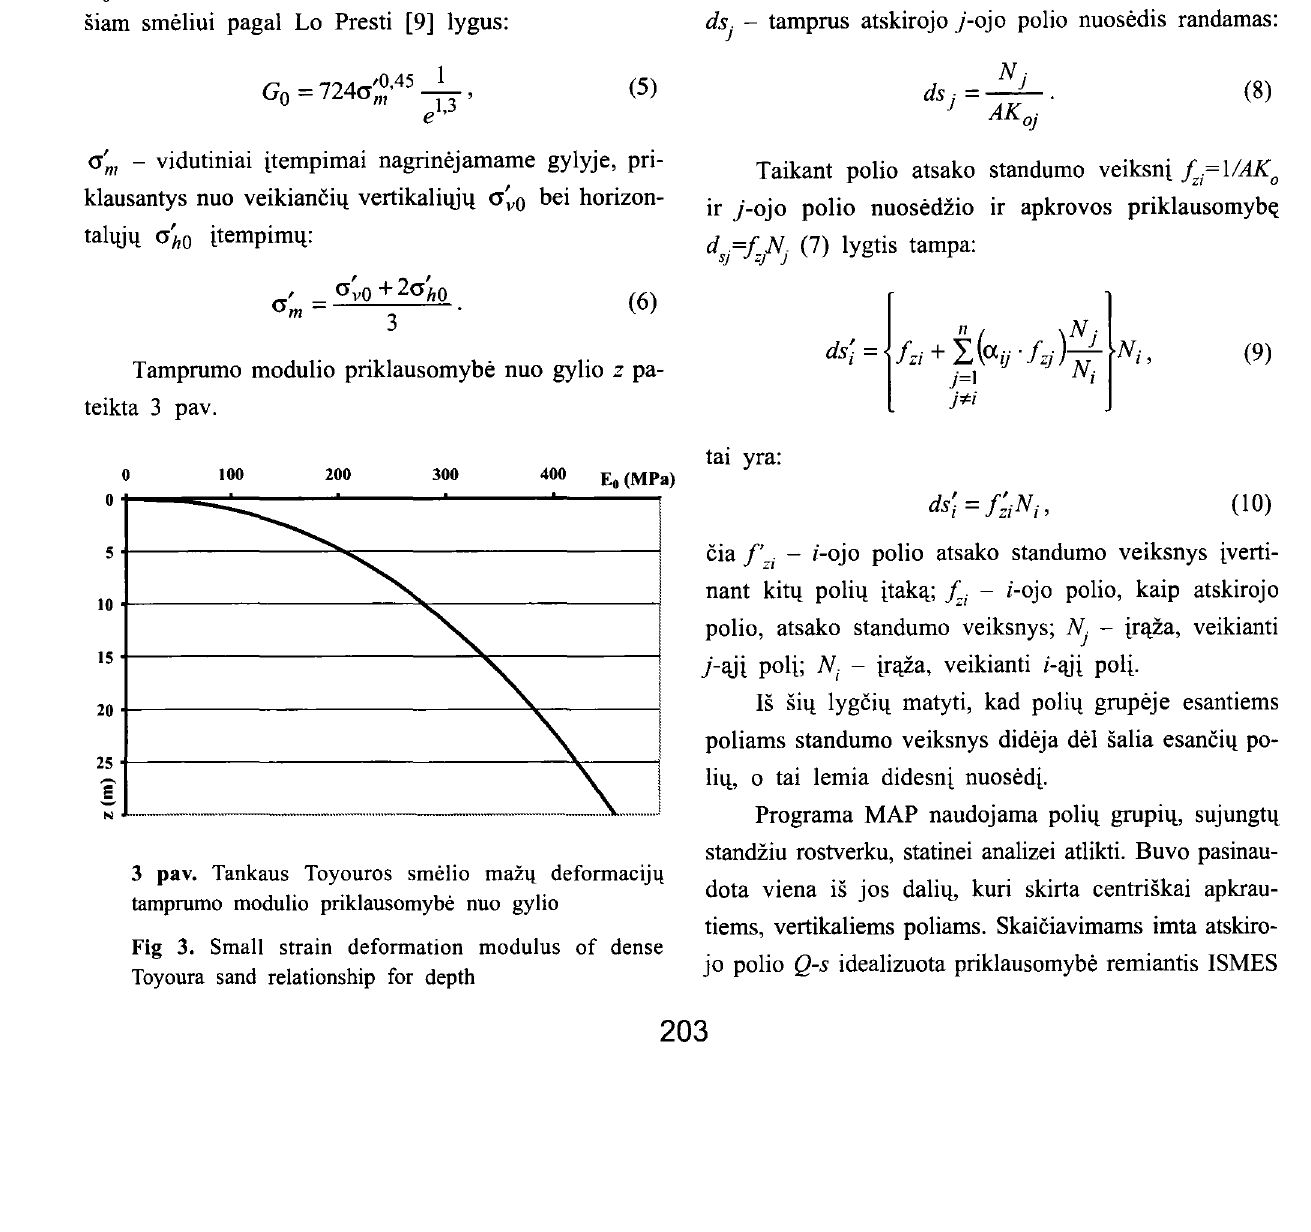
Fig 3. Small strain deformation modulus of dense Toyoura sand relationship for